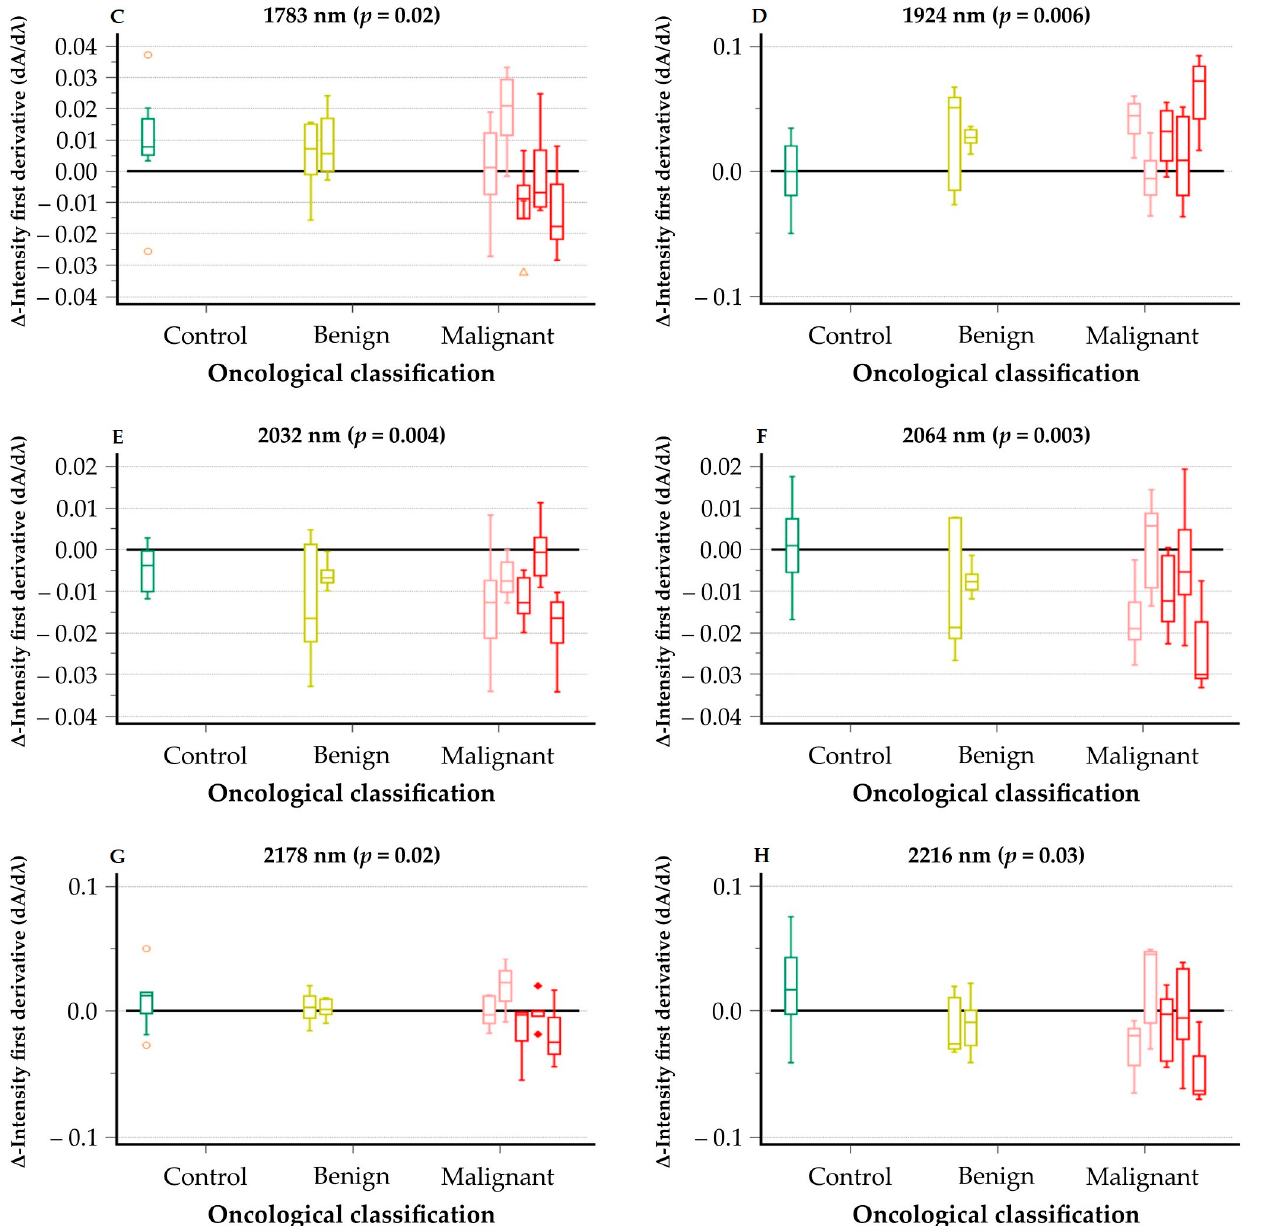
Figure 4. Box-and-Whiskersplot of ∆ -intensity of SGT for most significant NIR wavelengths with corresponding p-value: ( A ) wavelength 1436 nm; ( B ) wavelength 1712 nm; ( C ) wavelength 1783 nm; ( D ) wavelength 1924 nm; ( E ) wavelength 2032 nm; ( F ) wavelength 2064 nm; ( G ) wavelength 2178 nm; ( H) wavelength 2216 nm. All SGTs listed from left to right are as follows: control group (green); pleomorphic adenoma (myxoid, mixed, and cellular variant; yellow) and Whartin tumor (yellow); acinic cell carcinoma (light red) and adenoid cystic carcinoma (light red); epithelial myoepithelial carcinoma (dark red), mucoepidermoid carcinoma (dark red), and salivary duct carcinoma (dark red). Significance has been indicated in the